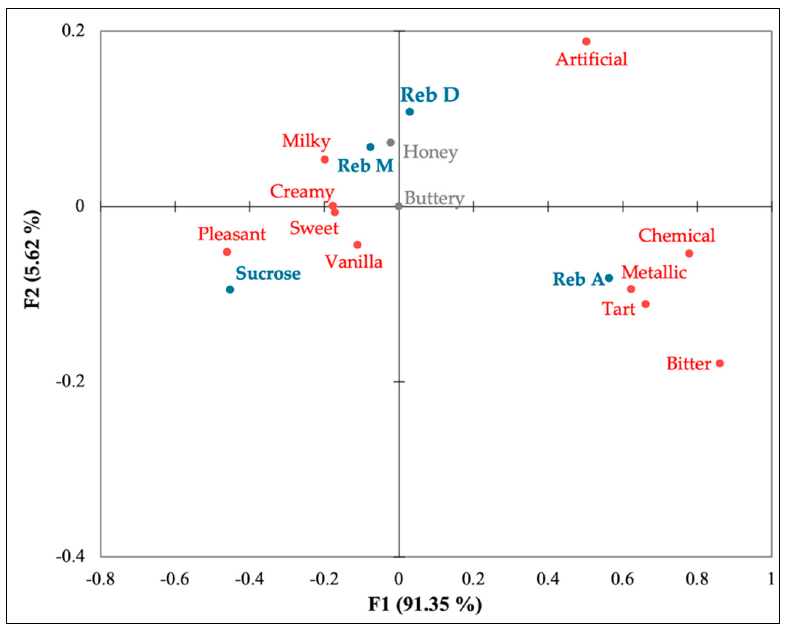
Figure 1. Correspondence analysis (CA) of each ice cream. Blue indicates samples; red indicates significant attributes; grey indicates not − significant attributes.